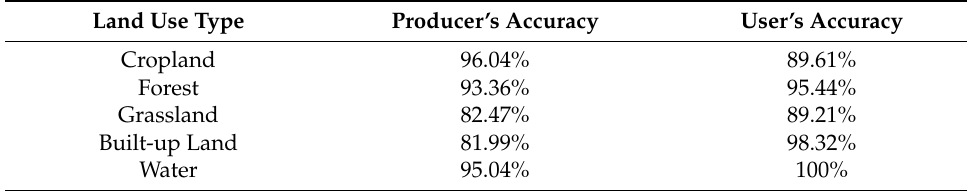
Figure 5. Overall accuracy and kappa coefficients for 2011–2020. Table 2. Mean PA and UA for different land use types from 2011 to 2020.